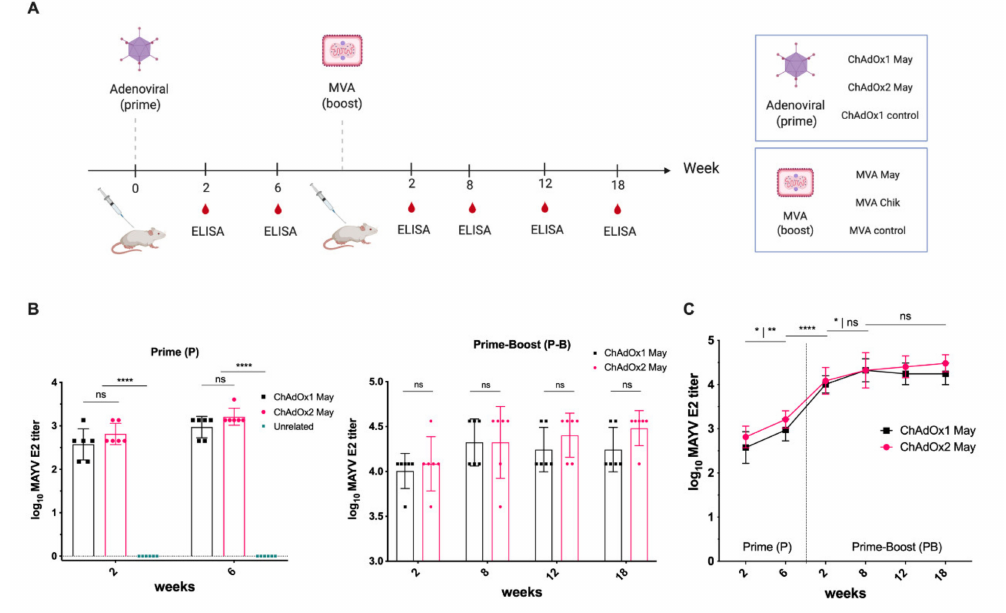
Figure 3. Description of vaccination regimen and immunogenicity elicited by ChAdOx1/ChAdOx2 -MVA MAYV vaccines. ( A ) A group of BALB/c mice ( n = 6) were immunised with ChAdOx1 May or ChAdOx2 May. Unrelated ChAdOx1 DENV NS1 vaccine was used as a control. All mice were boosted with MVA encoding the same antigens. Serum samples were collected at 2 or 6 weeks after prime immunisation and 2, 8, 12, and 18 weeks after P-B immunisations. ( B ) Humoral IgG responses elicited by the vaccines after prime ( left ) or prime-boost ( right ) were quantified by ELISA in plates coated with MAYV E2. The reciprocal log MAYV E2 ELISA titers were calculated for all groups. ( C ) MAYV E2 specific antibody body titers over time are shown as kinetics. Coloured lines represent the mean with SD ( n = 6 per group) and error bars. p values were determined by one-way ANOVA and Tukey’s multiple comparisons test. p > 0.05 (ns), p < 0.05 (*), p < 0.01 (**), and p < 0.0001